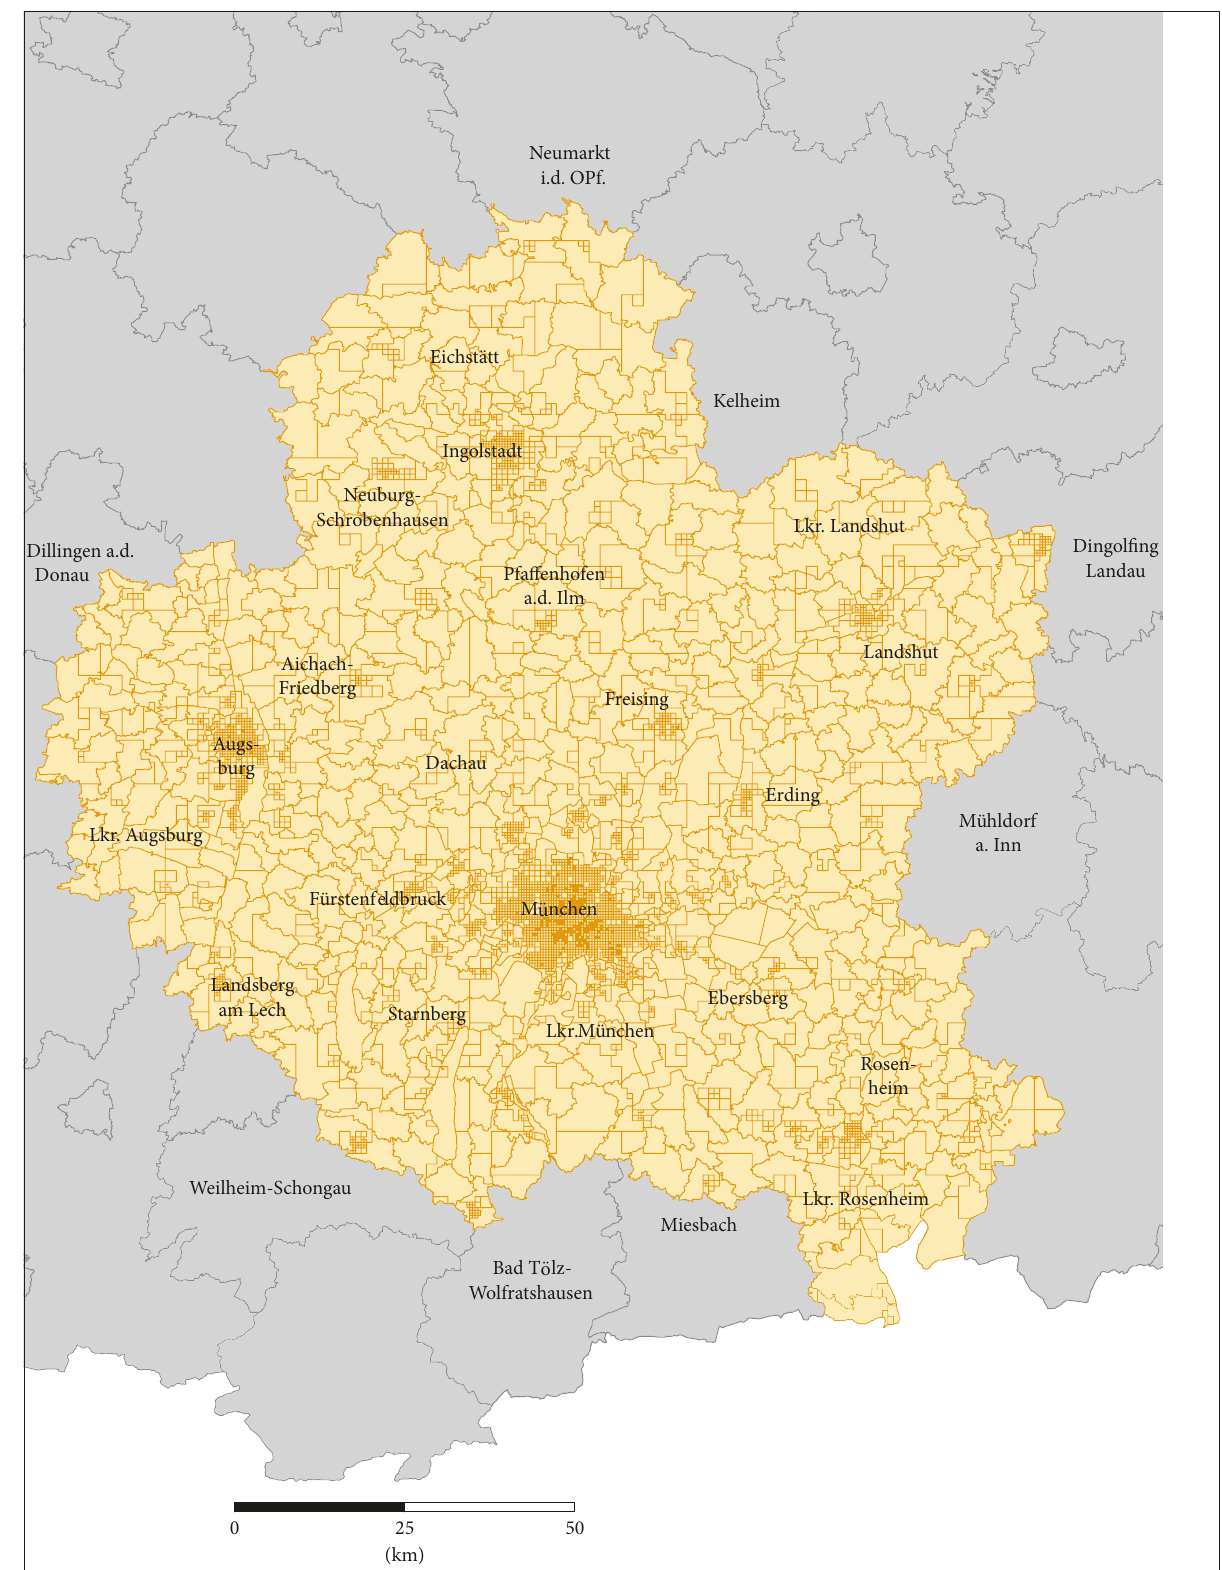
Figure 2: Greater Munich metropolitan area: counties and traffic analysis